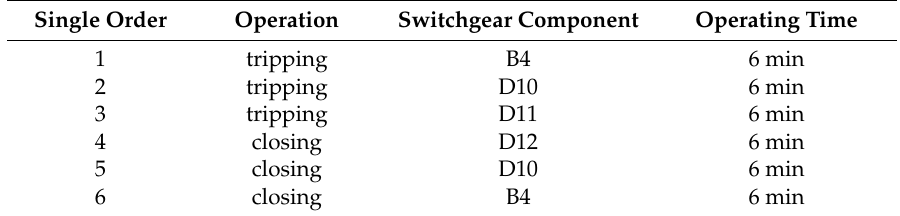
Figure 11. Double-bus scheme for bus 13. Table 6. The dispatching order ‘Change operational bus from bus 13 #1 to bus 13 #2 for line 12 –13′.